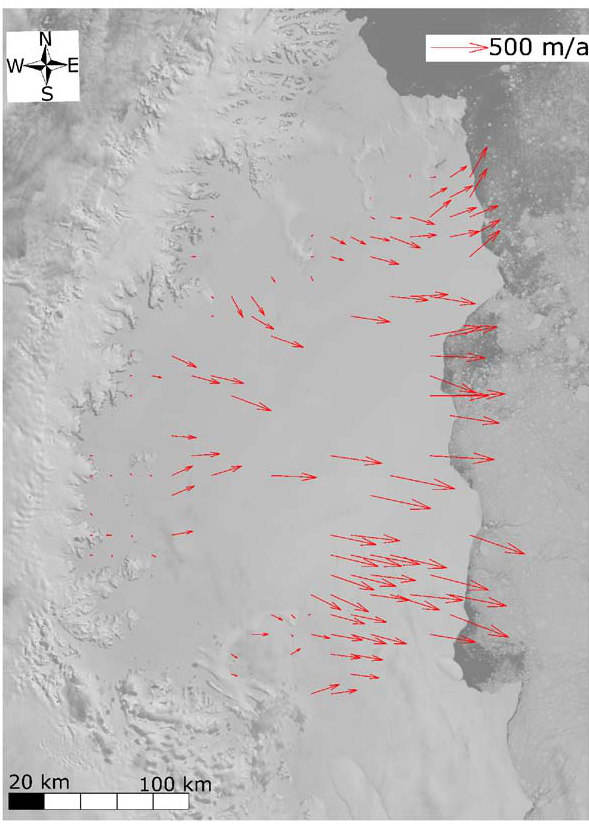
Fig. 8. Average annual velocity between 2006 and 2009 measured with normalized cross-correlation using a window size of 44 × 44 pixels (the same as used for the orientation correlation) on MODIS